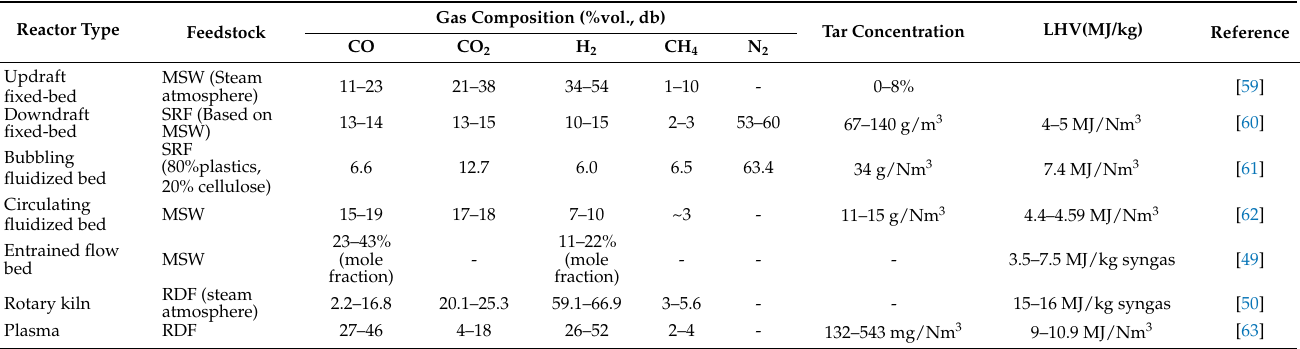
Table 2. Performance of different gasification